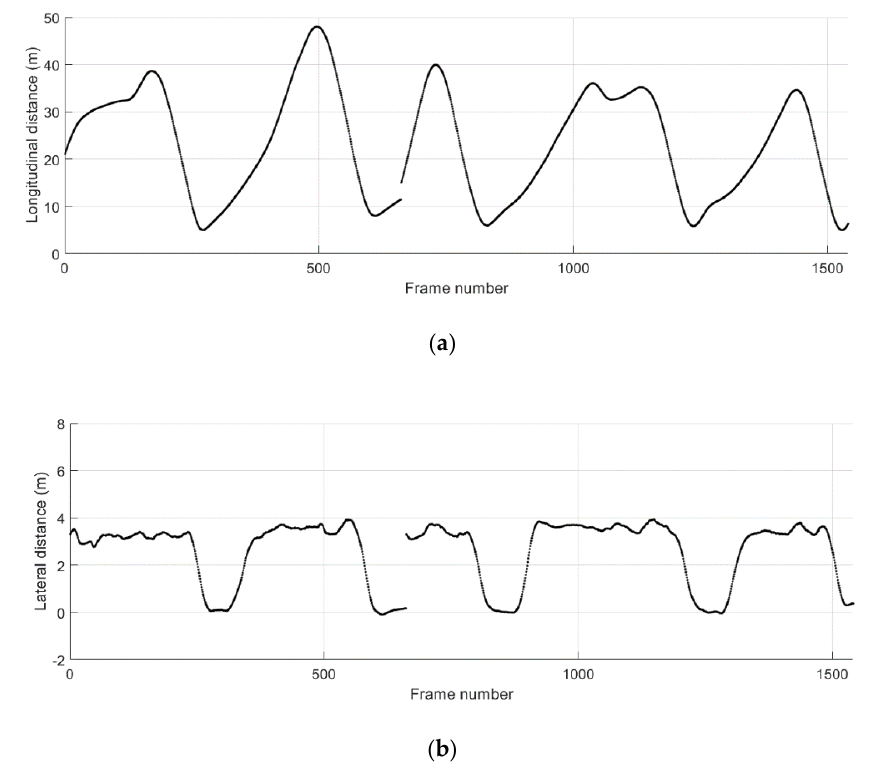
Figure 14. Potential crash events predicted during the cut-in driving scenario 1. ( a ) Time-to-collision (TTC); ( b ) collision warning level.